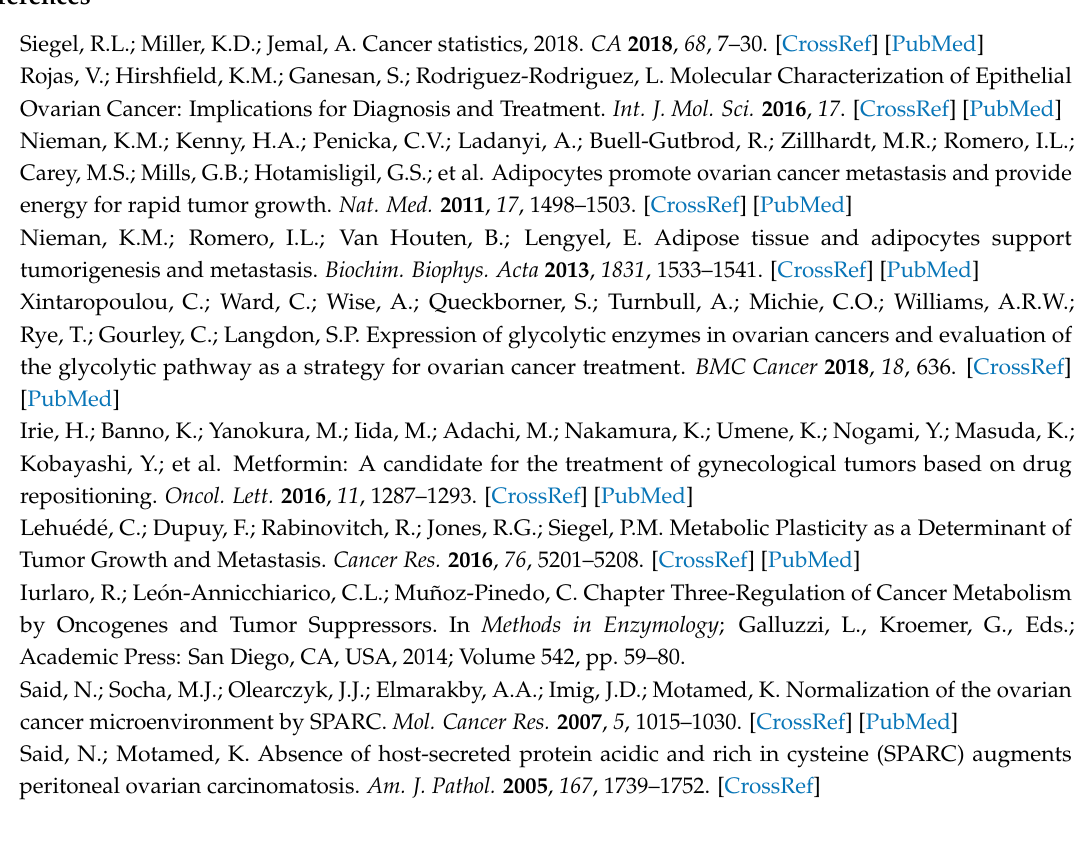
Figure S1: Effect of SPARC on activity of HK2 and TPI1 in human and murine OvCa cell lines. Ovarian cancer cell lines were treated with increasing concentrations of rSPARC for 24 h and the enzyme activity was determined as described in Materials and Methods. Bars mean ± SEM of a representative experiment that was repeated twice with reproducible results (n = 3/experimental condition/experiment). One-way ANOVA with Tuckey’s post-hoc multiple comparisons’ test, Figure S2: Scores of expression scores of immunostaining of syngeneic tumor tissues in Figure 9D. Box plots of IHC scores of the indicated protein expression in syngeneic tumors before and after phenformin treatment. p < 0.05 Mann-Whitney test, Table S1: Pathway Analysis of Overlapping Genes and Metabolites using Integrated Molecular Pathway Level Analysis (IMPaLA), Table S2: Oncomine analysis of mRNA/copy number of SPARC-regulated genes involved in glycolysis, TCA cycle, and oxidative phosphorylation in tumor tissues from patients with HGSC compared to normal tissues in the referenced studies, Table S3: Mouse primer sequences